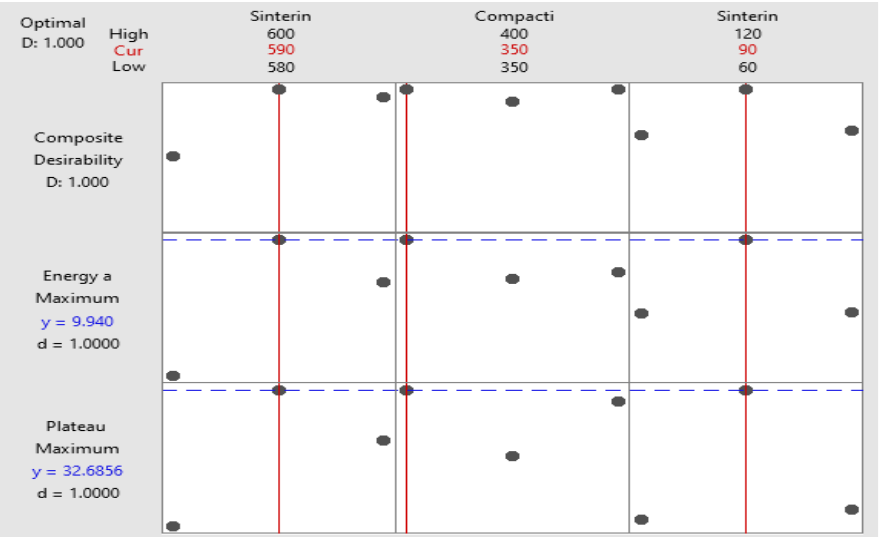
Figure 12. Optimization plot for plateau stress and energy absorption capacities (black point represent the output data, red lines join the maximum values of outputs obtained at some optimal parameters and blue line shows the optimal output values). Table 10. Response optimization: processing